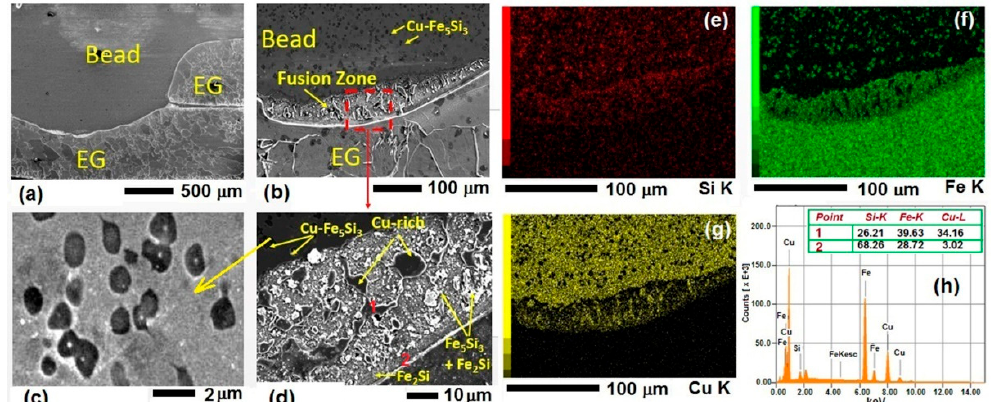
Figure 8. The microstructure of the bead cross-section and its composition. ( a ) The SEM image of lap joint, ( b ) the fusion zone, ( c ) the morphology of flower structure CuFe 5 Si 3 , ( d ) high-resolution image of fusion zone. ( e – g ) elemental maps of Si, Fe, and Cu obtained from SEM image of ( b ), ( h ) the EDS spectrum of ( d ). The atomic percent values are given in the table. Table 2. Gibbs free energy of various Fe-Si compounds [14].